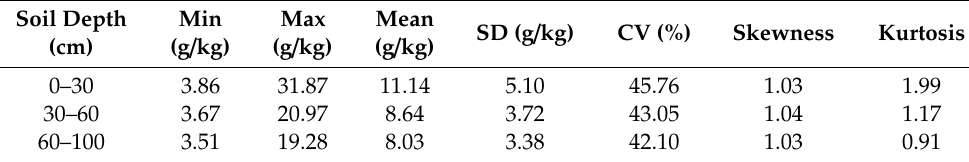
Table 2. Descriptive statistics of wetland soil organic carbon concentration (SOCc).